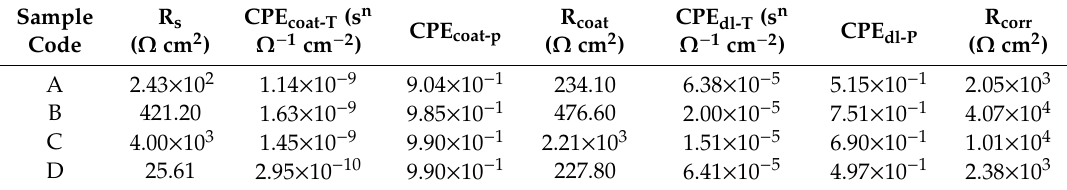
Table 4. The EIS parameters for the scratched coatings and immersed in the 0.5 M HCl.